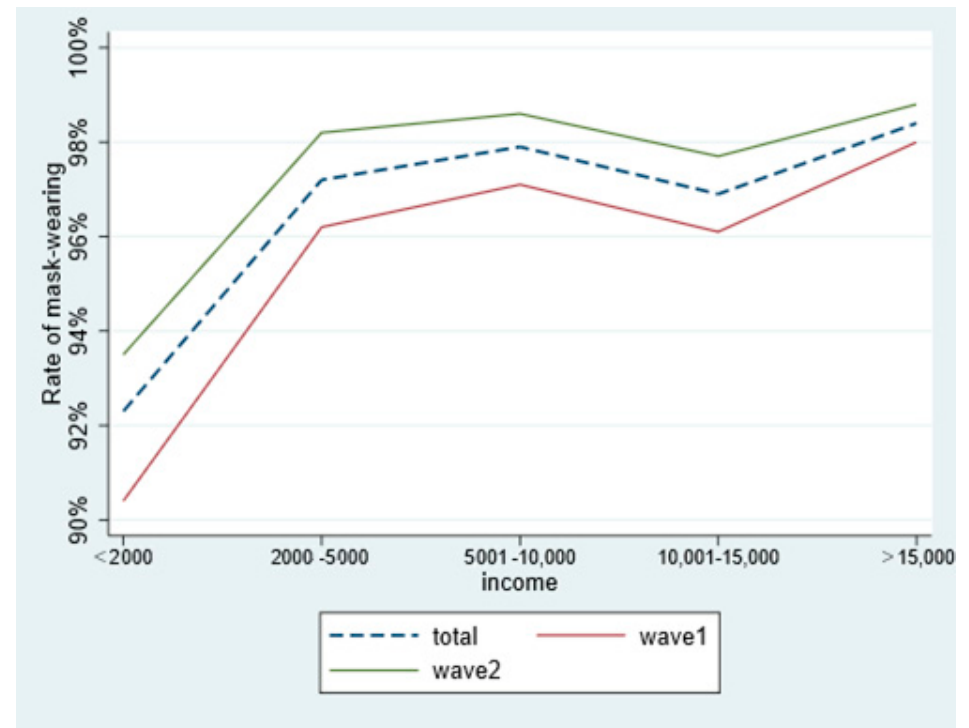
Figure 3. Comparison of the rate of wearing mask people with monthly income in two surveys.